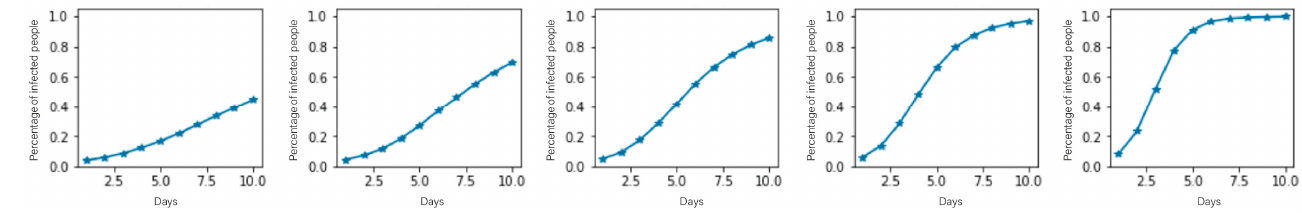
Figure 7. Influence of different node degrees (cid:1839) (cid:2868) on the number of policy